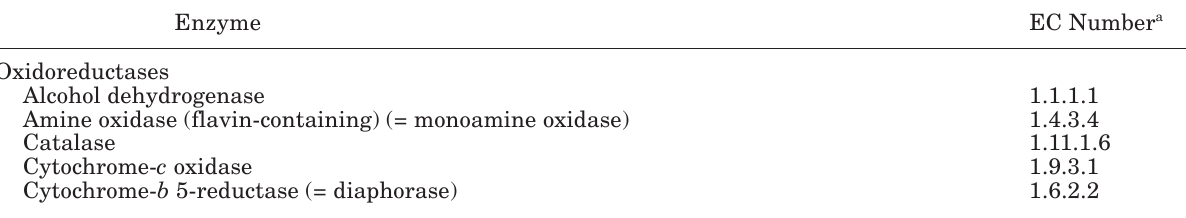
Table 4. Enzymes used in the electrophoretic analysis of plant-parasitic nematodes.